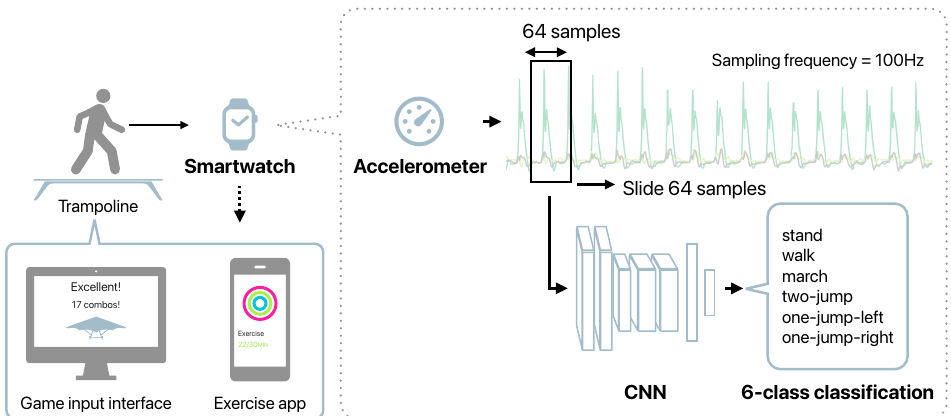
Figure 1. Outline of the proposed